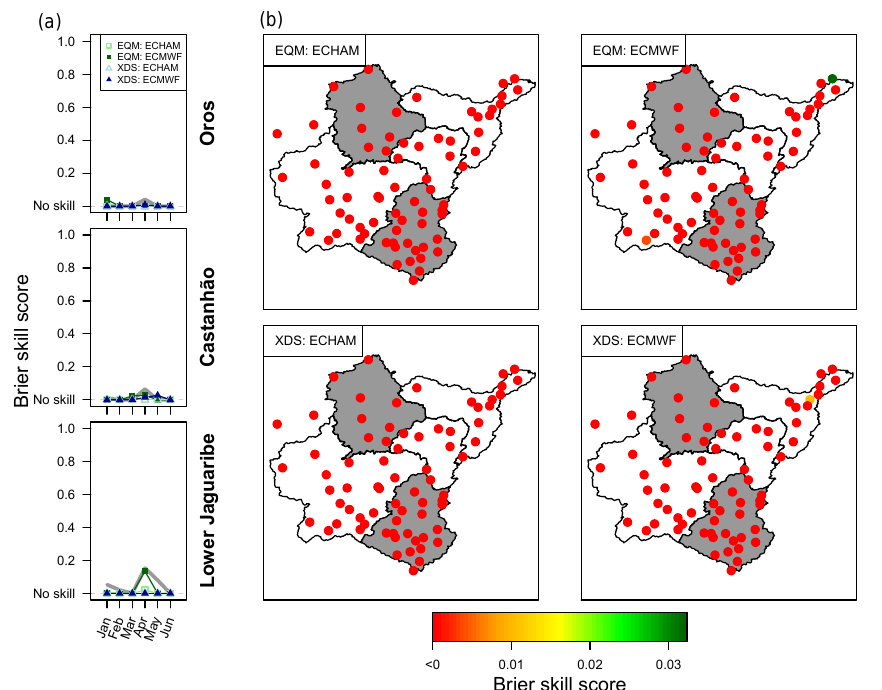
Figure 4. BSS of the forecast of a monthly low precipitation event. (a) The BSS is shown for each model/downscaling combination and for the forecasting months averaged over the respective subcatchments. BSS values below zero were assigned a “no skill” category in order to improve readability. The grey line is the BSS of the multi-model ensemble. Panels (b) show BSS averaged over all forecasting months for each station. Note that in most cases the forecast of monthly precipitation has no skill.